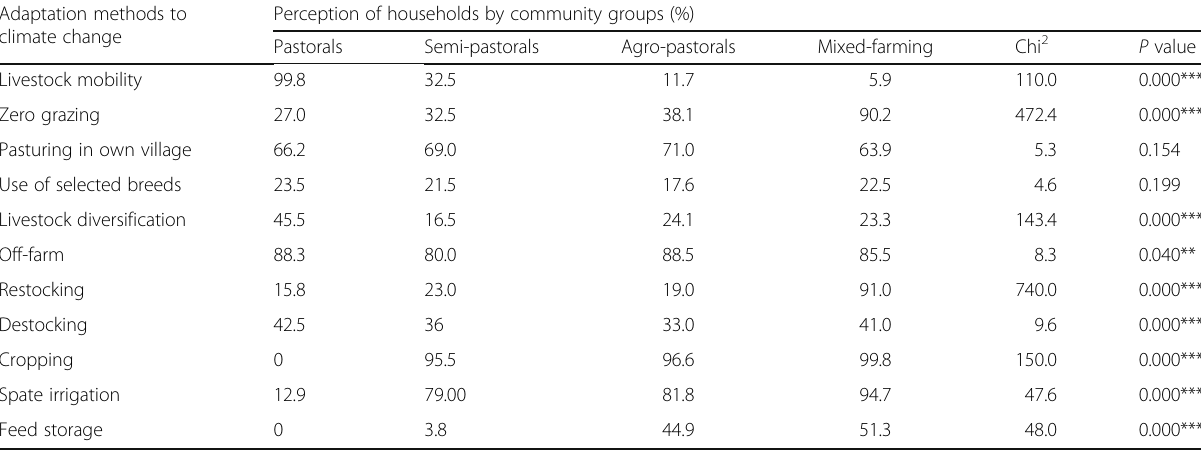
Table 3 Association of household ’ s perception with various adaptation strategies Adaptation methods to climate